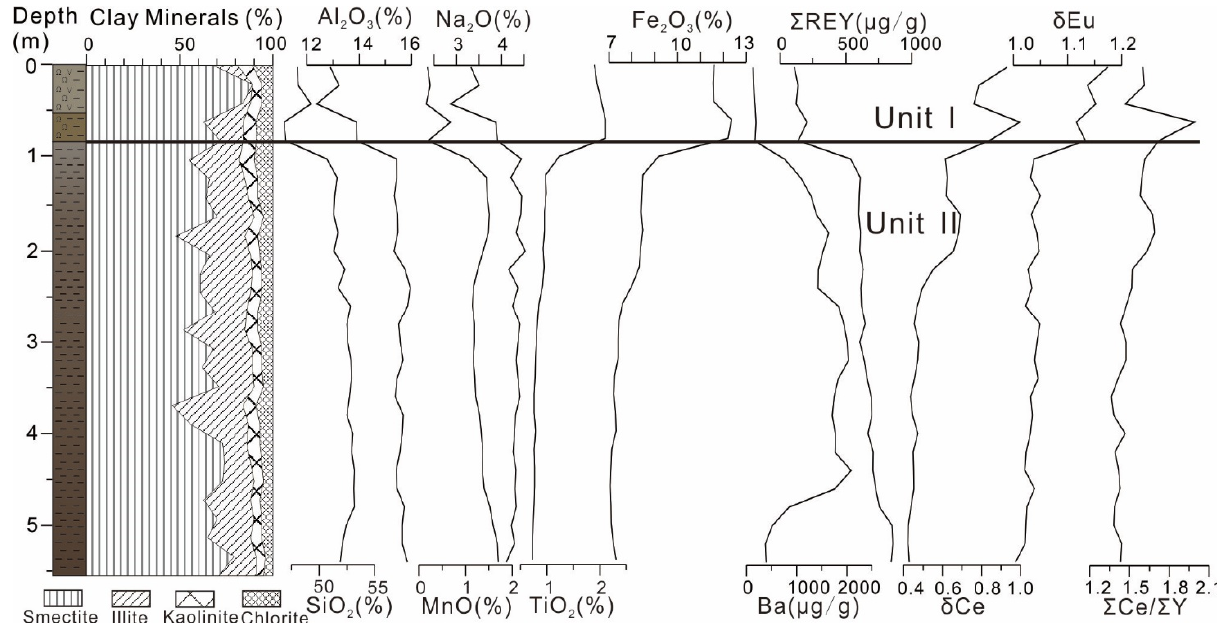
Figure 6 . Stratigraphic changes in clay minerals, and major, trace and rare-earth elements in core PC15.